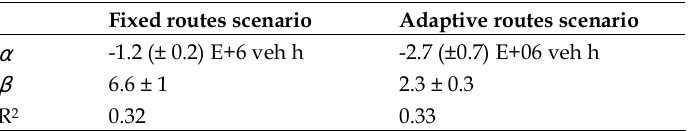
Figure 5. Comparison of the impacts of link closure in scenarios between spillback simulations and non- spillback simulations. Table 1. The fit parameters for the relationship between the non-spillback performance and the spillback